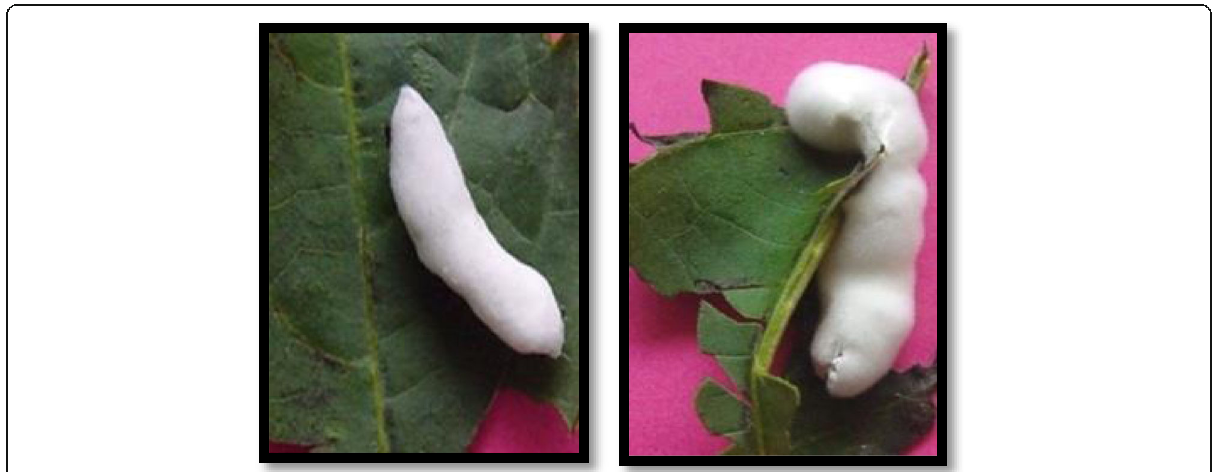
Fig. 5 Beauveria bassiana infection on Spodoptera litura larvae on the seventh day. White fluffy fungal mycelium is seen covering whole of the